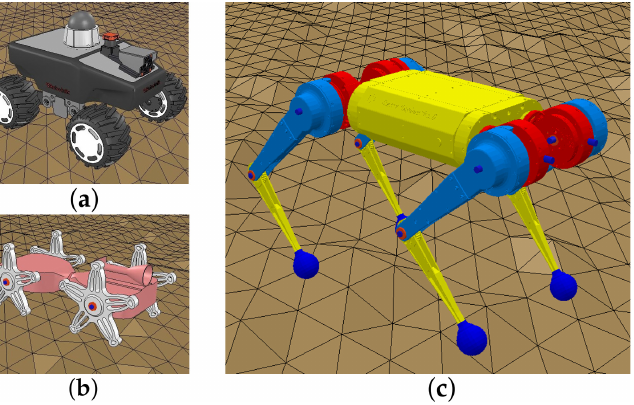
Figure 6. Different robotic structures taken into consideration for the tests in the complex terrain: ( a ) the Summit-XL; ( b ) the Asguard; ( c ) the Mini